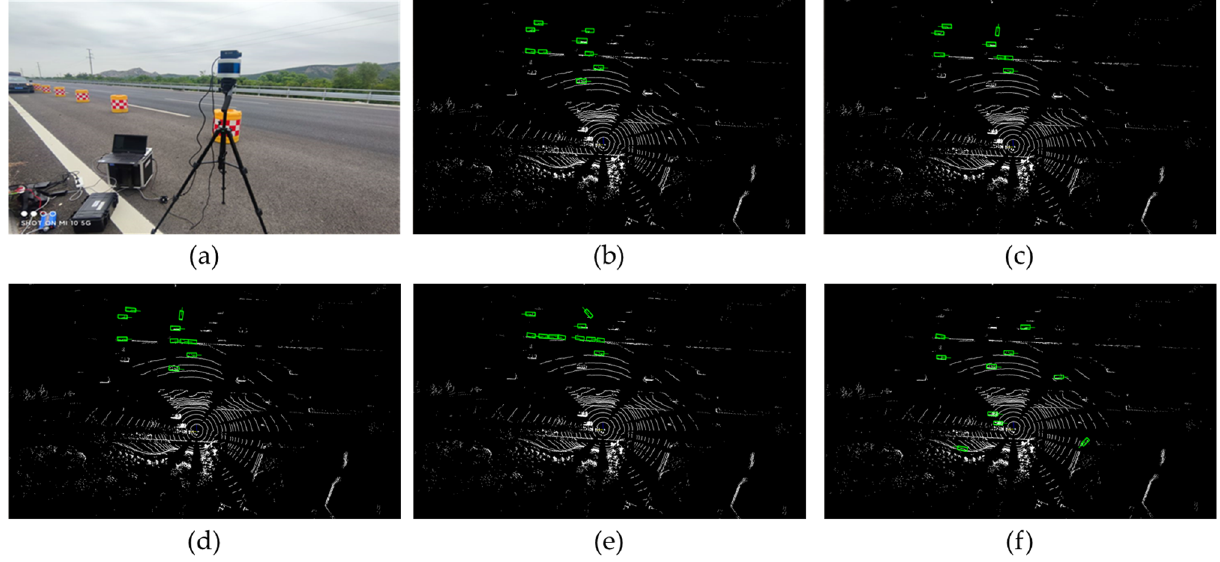
Table 5. The Performance of different detection algorithms.